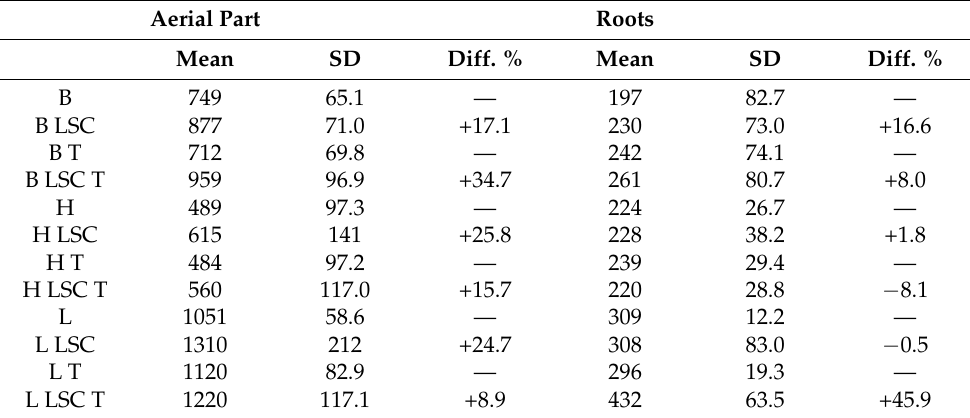
Table 6. Dry weight (mg) of the biomass of the aerial part and of the roots of plants. Values are reported as mean ± standard deviation (SD).